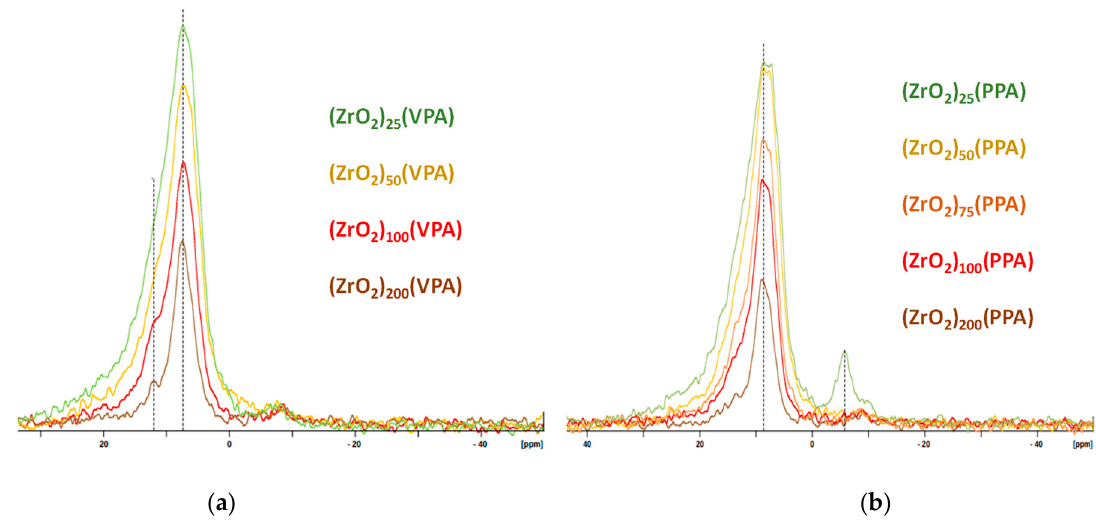
Figure 3. 31 P CP MAS NMR spectra of ( a ) (ZrO 2 ) x (VPA) and ( b ) (ZrO 2 ) x (PPA) samples (Zr/P ratio ( x ) = 25–200).